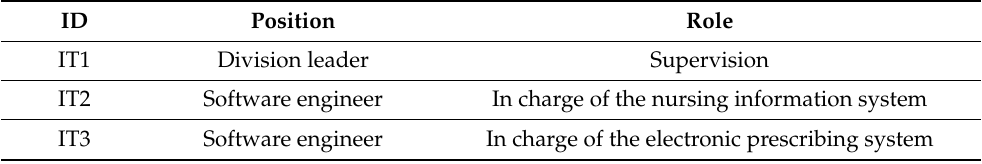
Table 1. Informatics staff participants ( n =